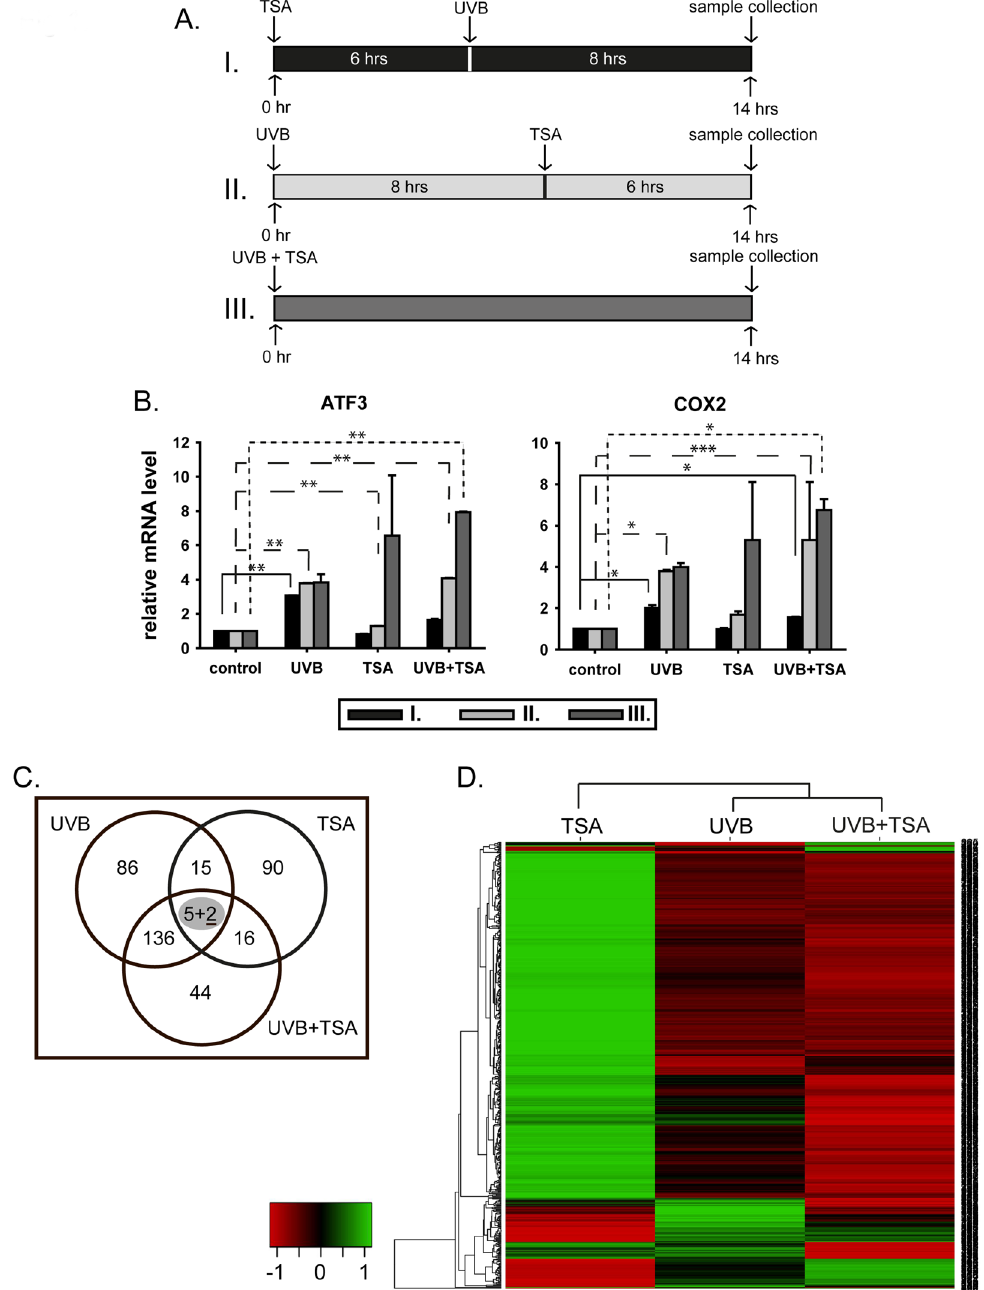
Figure 1. UVB-induced expression level of ATF3 and COX2 influenced by TSA. HKerE6SFM cells were treated with high doses of UVB and HDAC inhibitor TSA in different combinations. ( A ) Treatment combinations are illustrated in panel A, rows I, II and III. ( B ) The mRNAs were isolated 14 hours after the first treatment and the expression levels of ATF3 and COX2 were analysed by qPCR. The means and standard deviations of five independent experimental triplicates are indicated as fold-expression compared to the control. Standard deviations and statistical significances are shown. Star indicates statistical significance between the dataset (paired Anova * P < 0.05, ** P < 0.01, *** P < 0.001, **** P < 0.0001). Legends for the X-axis are control (no treatment), UVB (only UVB no TSA), TSA (only TSA no UVB) and UVB + TSA (both UVB and TSA). Graph legends (I, II and III.) correspond to UVB and TSA treatment indicated in Panel A. ( C ) Plot of genes differentially expressed in HKerE6SFM cells upon UVB, TSA or UVB + TSA combined treatment in microarray experiments. Circles represent groups of genes modified by UVB, TSA and UVB + TSA treatments compared to the control, respectively. Numbers indicate the number of genes showing altered mRNA levels by one or more stimuli. Underlined, bold number: superinduced genes in UVB + TSA samples (compared to UVB treated samples). ( D ) Heatmap representation of differential gene expression following UVB and TSA treatment. Only genes displaying alterations upon one or the other treatment are included in the map. Red and green colour indicates down- and upregulation, respectively. Expression changes are shown in a log 2